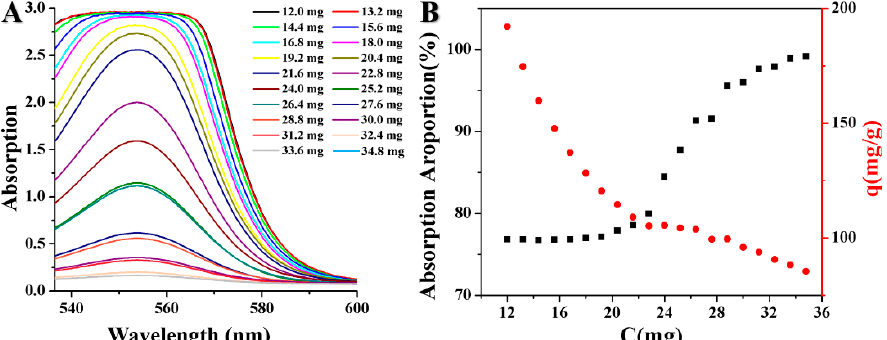
Figure 3. ( A ) Successive UV–vis spectra of the remaining Rhodamine B in the solution after magnetic separation of each composite dose treatment. ( B ) The removal proportion (%) of Rhodamine B and the adsorption capacity of magnetic porous carbon of each adsorbent dosage.